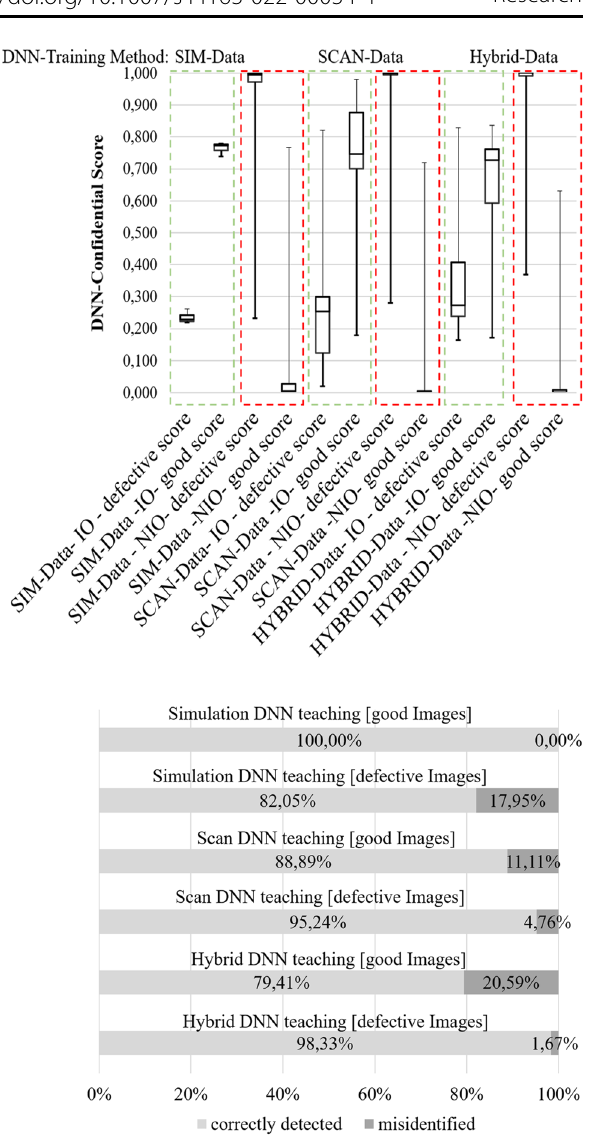
Fig. 11 Comparison of cor- rectly and misidentified test- parts according DNN-training